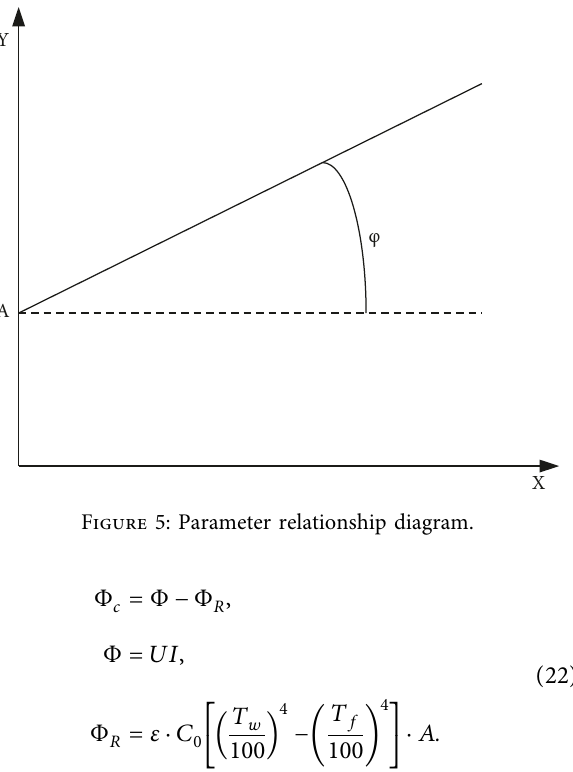
Figure 5: Parameter relationship diagram.